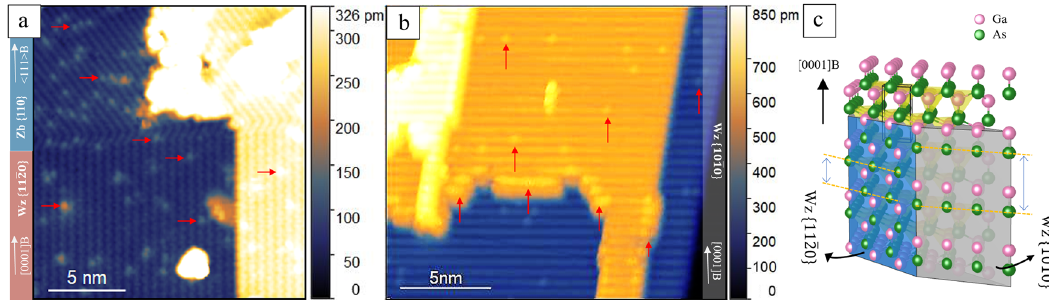
Fig. 3 Atomically resolved STM images of Bi incorporation in GaAs NW surfaces with a lower step density. a shows the interface between a Wz f 11 (cid:1) 20 g - (bottom) and a Zb {110}- (top) type facet. In this image, no step edge facing [0001]A/B directions is present on the Wz f 11 (cid:1) 20 g facet. Almost all Bi atoms are incorporated at individual sites. In contrast, the Zb {110} facet includes more Bi atoms, in the form of unordered Bi clusters along the step edges or random individual Bi incorporation sites. b shows the surface of a Wz f 10 (cid:1) 10 g -type facet. At all step edges facing [0001]-type directions, most of the As atoms are substituted by Bi, while very few Bi incorporation sites are found on the other step edges or within the terraces. The slightly tilted appearance of the step edges is explained in Supplementary Note 2. Some Bi atoms are indicated in ( a ) and ( b ) by red arrows. The height scale bars are shown on the right side in both ( a ) and ( b ). c sketches the 30° edge between a Wz f 10 (cid:1) 10 g - and a f 11 (cid:1) 20 g - type facet, pink (green) spheres depict Ga (As) atoms. Every layer of Ga and As (or Bi) atoms along the [0001]B growth direction can be seen on the f 11 (cid:1) 20 g surface, resulting in the zig-zag chain pattern visible at high resolution as e.g., in Fig. 2d due to the AB-stacking sequence of the atomic layers. However, only every second layer of Ga and As (or Bi) atoms can be seen (cid:1) (cid:3) in the top most plane of the 10 (cid:1) 10 surface. STM images were obtained at ( a ) V T = − 4.4 V, I T = 50 pA and ( b ) V T = − 4.5 V, I T = 90